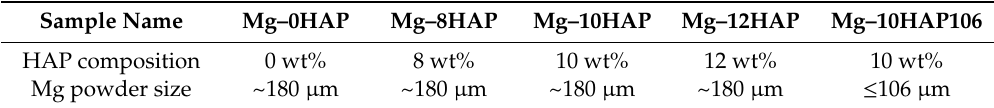
Table 1. Hydroxyapatite (HAP) composition and Mg powder size of each